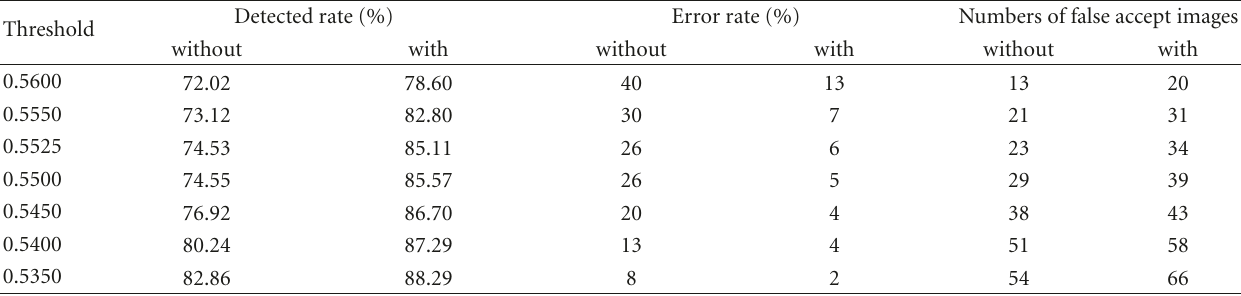
Table 1: The comparisons of face detectors between with and without lighting normalization.